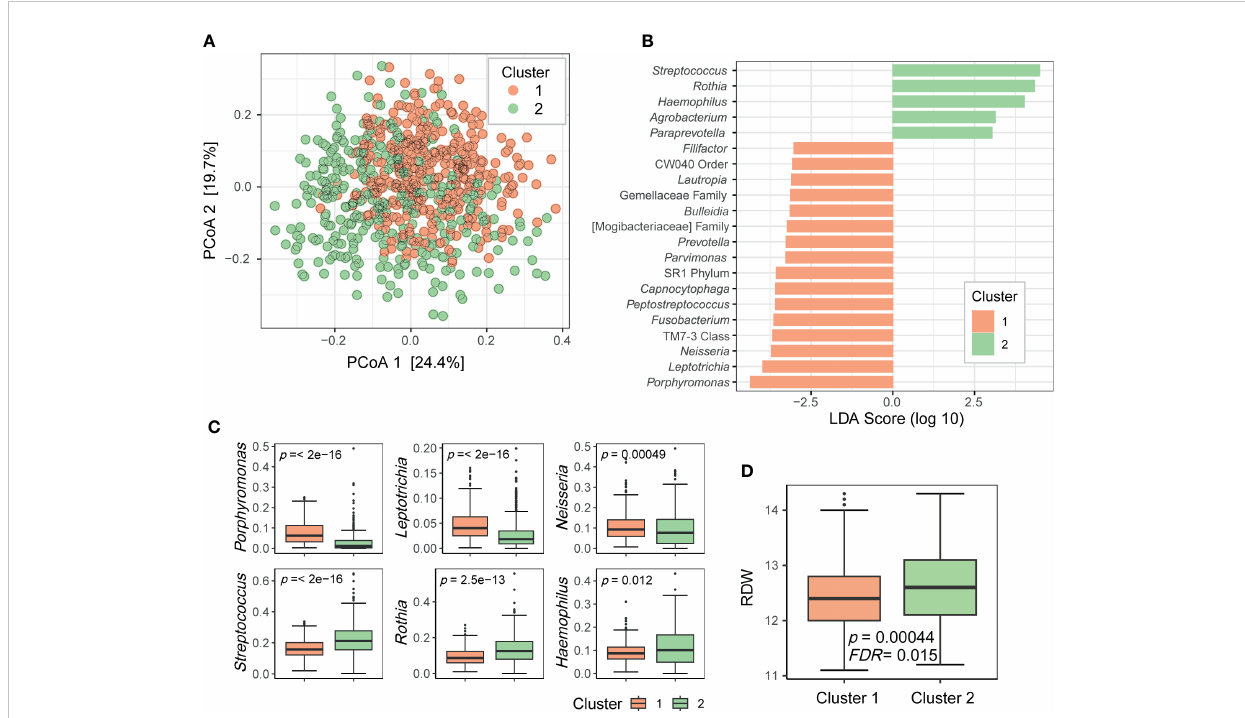
FIGURE 3 Clusters of the oral microbiome. (A) Principal coordinate analysis plot of the genus-level data based on the Bray – Curtis distance. Dots are colored by cluster. (B) Differentially prevalent genera in two clusters based on linear discriminant analysis effect size (LEfSe) analysis. LDA scores (log 10) > 3 are shown. (C) Boxplots of selected genera with differential relative abundance between clusters from LEfSe analysis. P -values on each plot were calculated using the Wilcoxon rank-sum test. (D) Red blood cell distribution width (RDW) levels associated with oral microbiome clusters. P -value was calculated using the Wilcoxon rank-sum test. FDR value was estimated to control for multiple